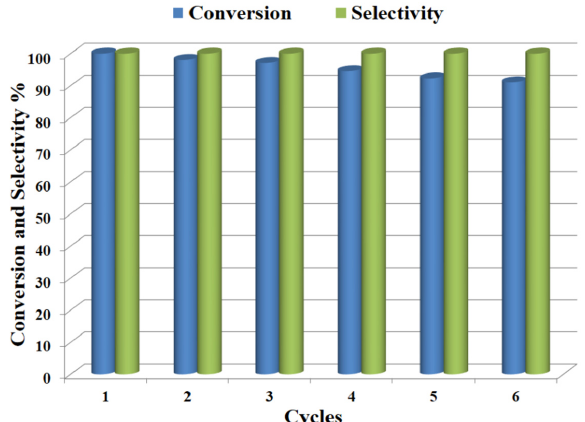
Figure 9. Stability and recyclability study of (1%)Co x O y –MnCO 3 catalyst in oxidation of BzOH, Conditions: 0.3 g (1%)Co x O y –MnCO 3 catalyst calcined at 300 °C, 2 mmol BzOH, 15 mL toluene, 25 mL/min O 2 rate, 100 °C, 20 min.